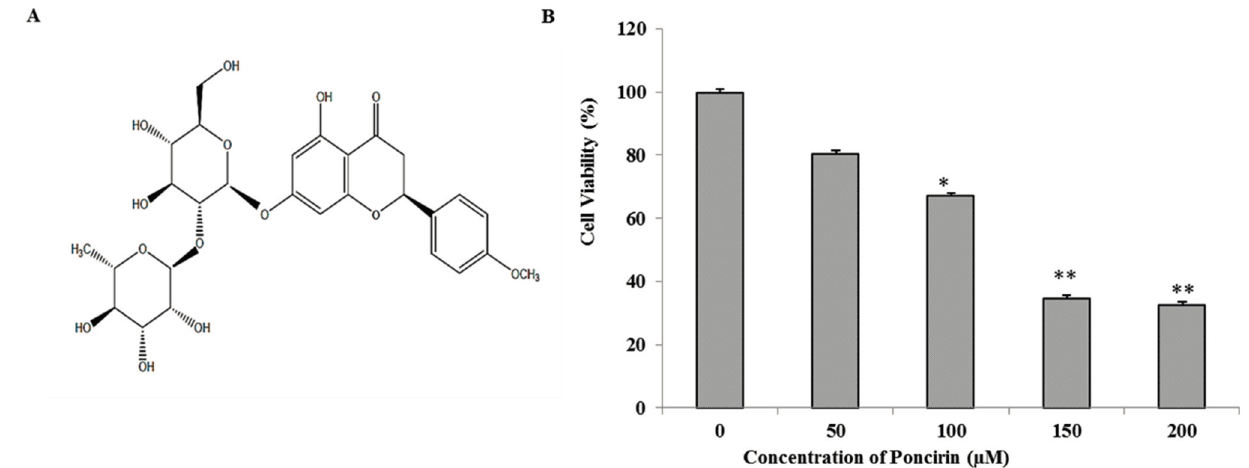
Figure 1. Growth inhibition by Poncirin in AGS human gastric cancer cells ( A ) Chemical structure of Poncirin; ( B ) AGS cells were incubated at indicated concentrations of Poncirin for 24 h. The cell viability was analyzed by 3-(4,5-dimethylthiazol-2-yl)-2,5- diphenyltetrazolium bromide (MTT) assay. The data are shown as means ± standard deviation (SD) of three independent experiments (* p < 0.05 and ** p < 0.01 vs.